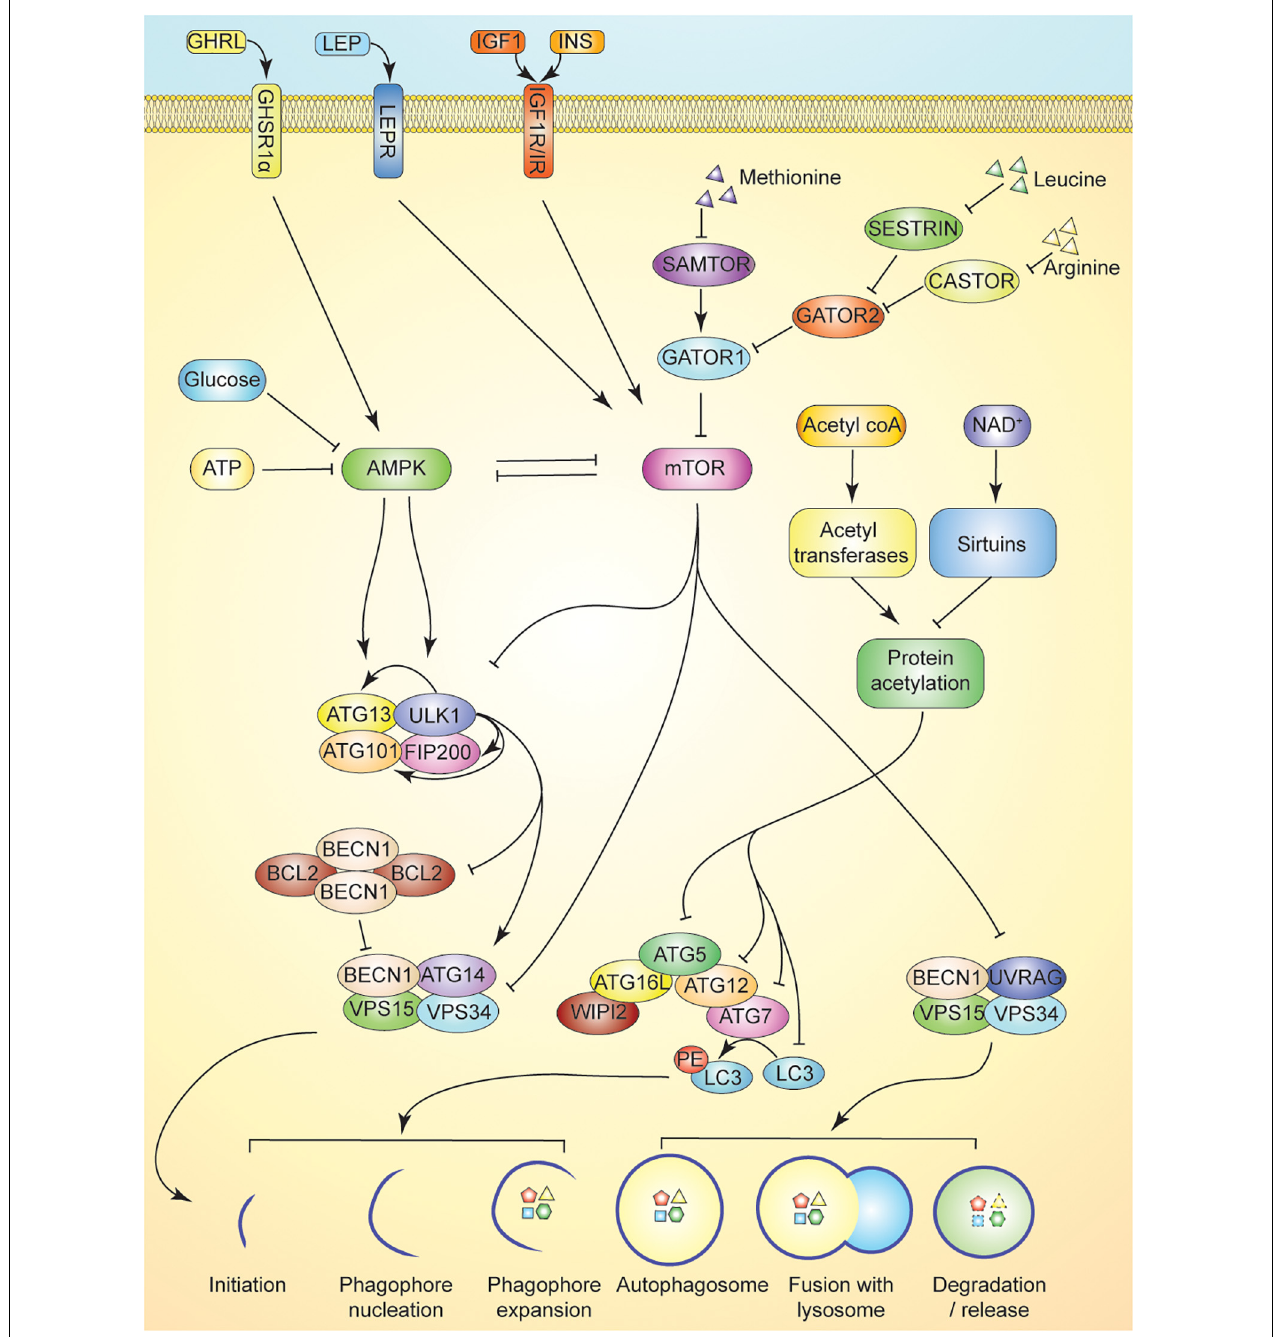
FIGURE 1 | Overview of autophagy and its regulation. Nutrient sensing in autophagy induction is multifaceted. Activation of the ULK serine threonine kinase complex induces autophagy by promoting release of BECN1 from BCL2 inhibitory heterotetramers, and promoting the association of BECN1 with ATG14, VSP15, and VSP34 in Class III PI3K complex I. This complex is responsible for initiating isolation membrane formation. AMPK activation in response to cellular energy status activates ULK complex by phosphorylation of ULK1 and ATG13. Activation of autophagy is antagonized by mTOR inhibition of AMPK, ULK complex, and Class III PI3K complex I and II. mTOR activity is maintained by intracellular leucine, arginine, and methionine levels. Leucine and arginine inhibit SESTRIN and CASTOR, respectively, to promote GATOR2 inhibition of GATOR1, a key negative regulator of mTOR activity. Methionine, through production of SAM inhibits SAMTOR to suppress GATOR1 activity. Activation of growth factor signaling via hormones upstream of mTOR (e.g., leptin, insulin, and IGF1) further suppresses autophagy. GHRL signaling in contrast can activate AMPK to promote autophagy. Maintenance of protein acetylation by acetyltransferases is enabled by ready supply of acetyl-coA and suppresses the activity of ATG5-ATG12 complex further limiting autophagy induction. Activation of sirtuins by elevation of NAD + levels promotes autophagy by reducing such inhibitory acetylation and enabling ATG5-ATG12 complex to lipidate LC3.